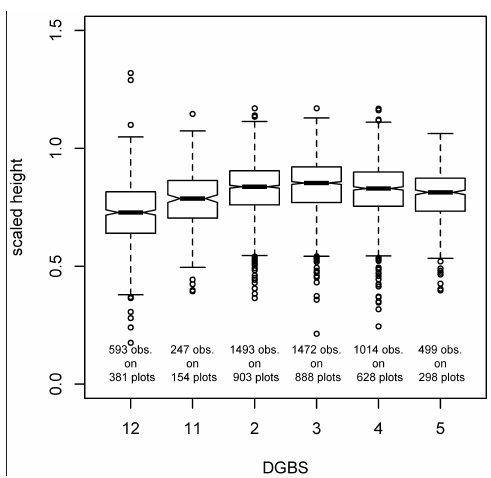
Figure 5. Boxplots of scaled heights for the